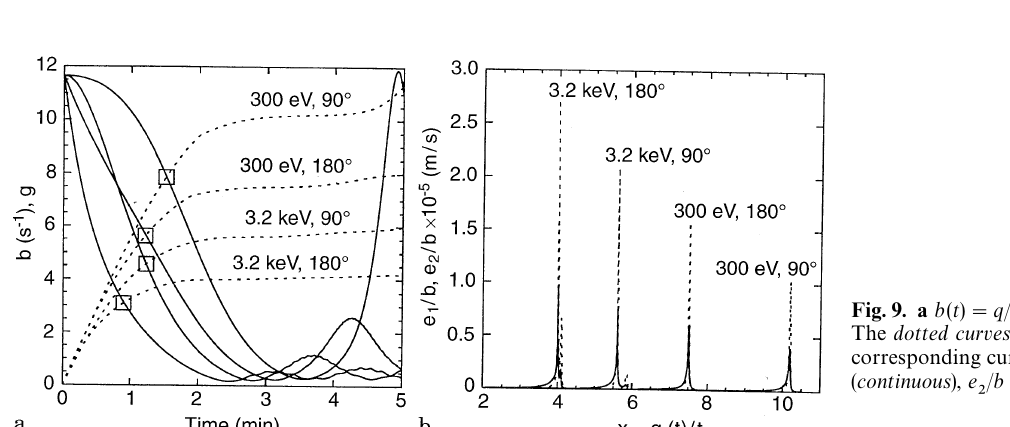
Fig. 8a (cid:177) d. The details of ions motion. a Magnetic moment; b cyclotron period, and c,d induced electric field components versus time